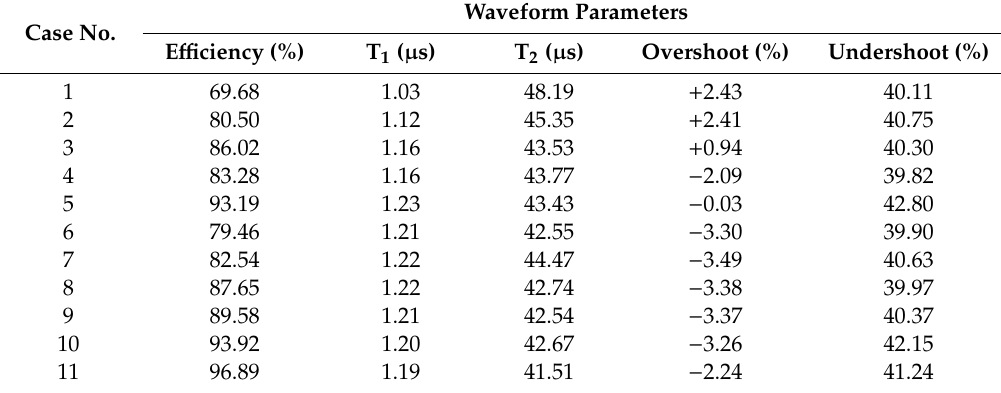
Table 7. The generated waveform parameters associated with the cases in Table 6. Case